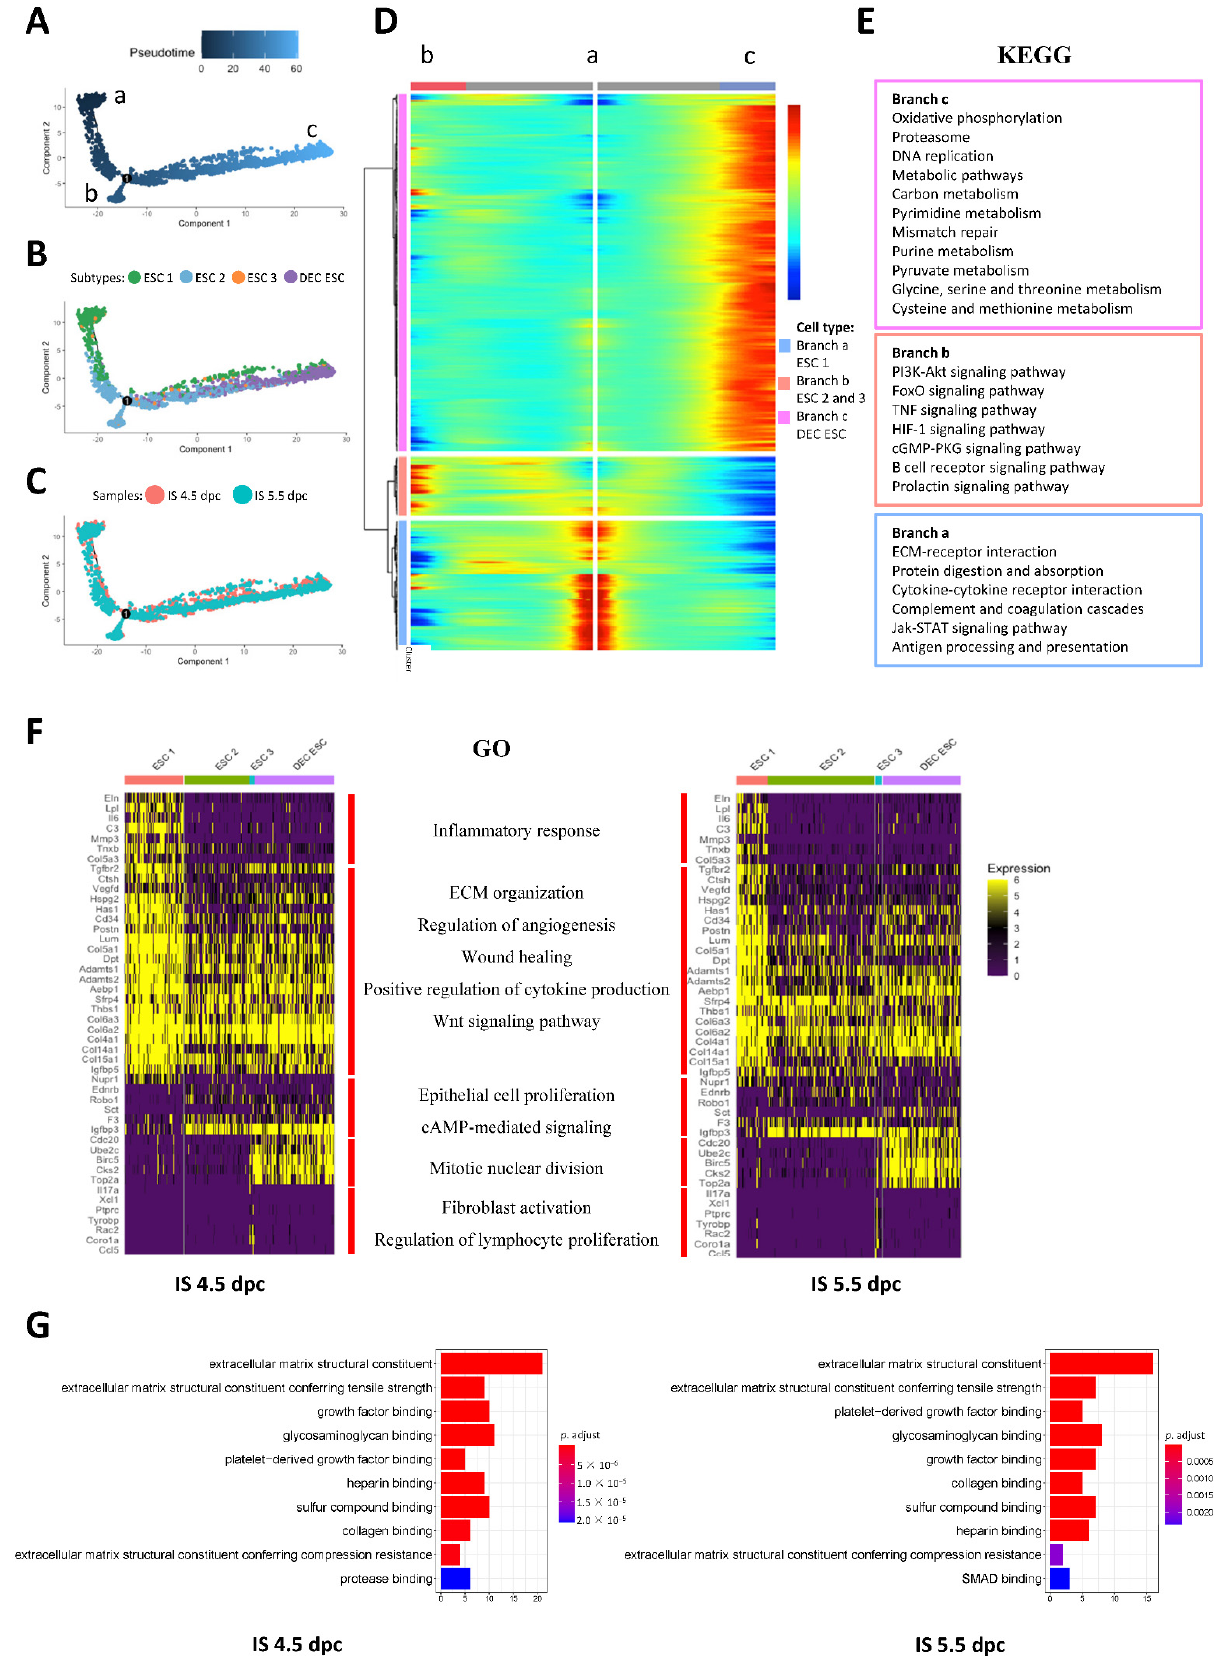
Figure 3. Functional analysis of ESC subtypes during early mouse embryo implantation.